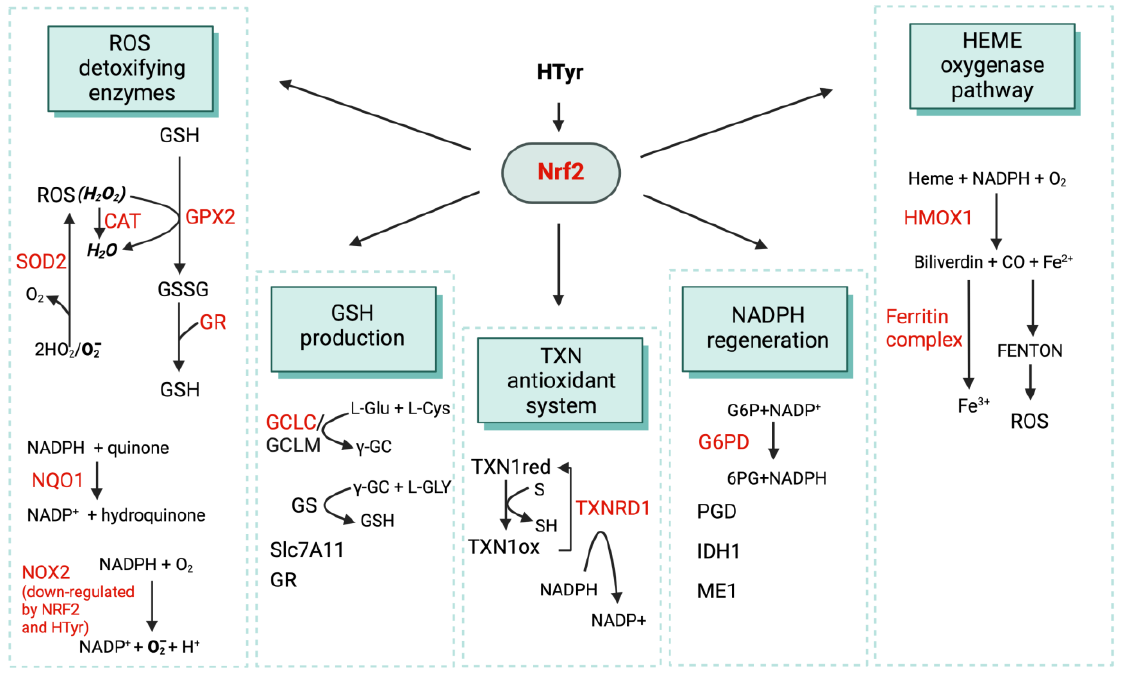
Figure 4. Schematic representation of the antioxidant effects of HTyr mediated by